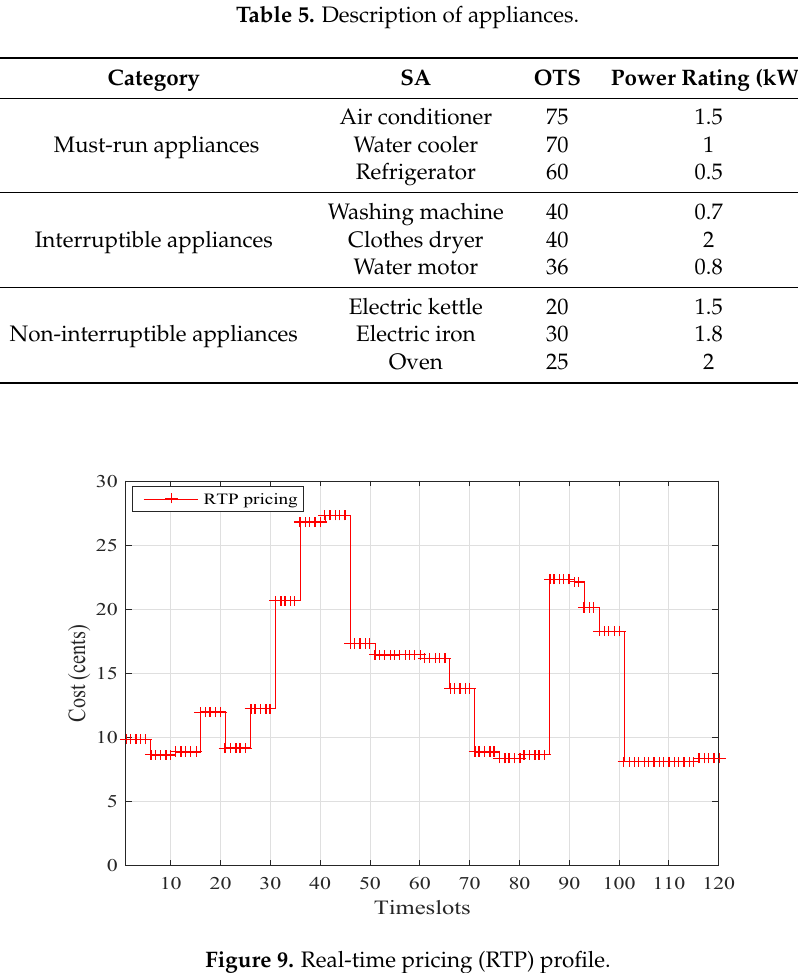
Table 5. Description of appliances.